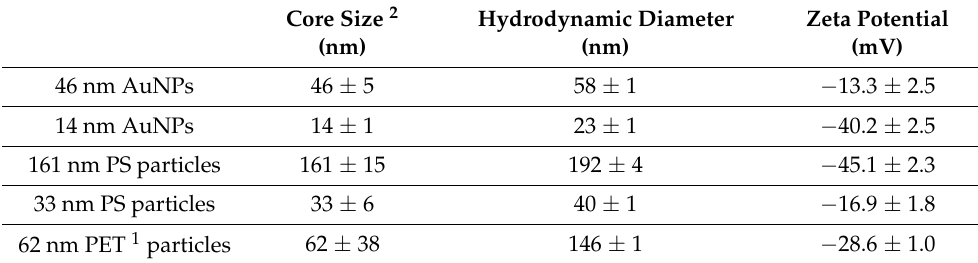
Table 1. Physicochemical characterization of the